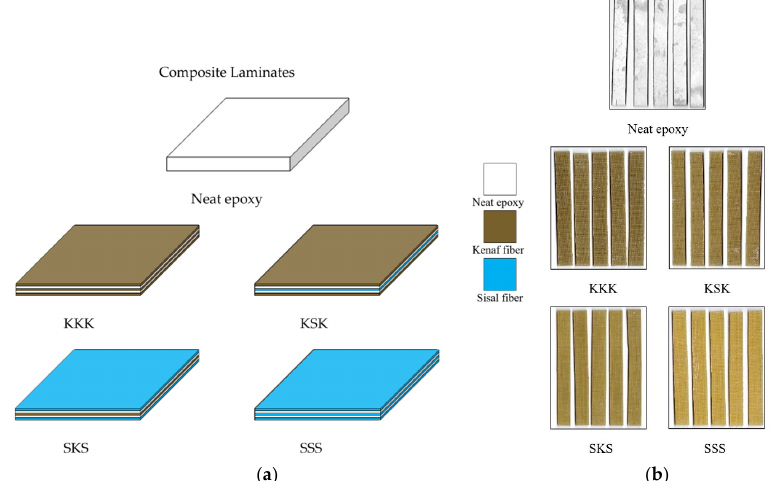
Figure 2. ( a ) Schematic of the composites prepared, ( b ) Photographs of composites after